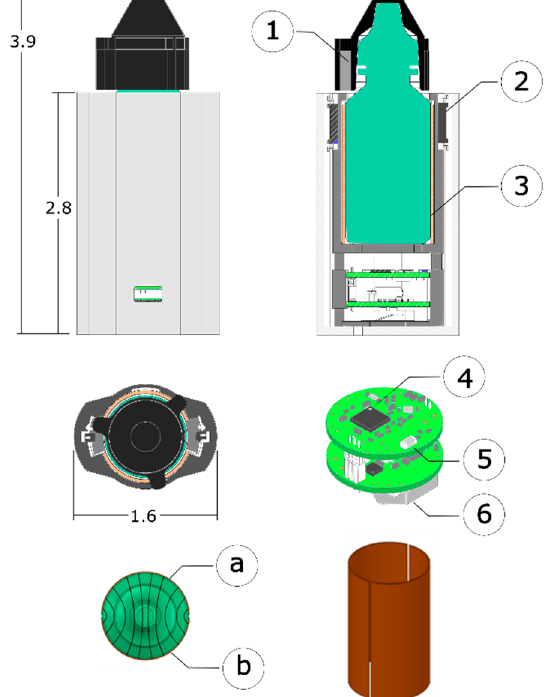
Figure 2. Mechanical layout of the bottle and sleeve assembly. ( 1 ) Bar magnets placed in the cap, and ( 2 ) reed switches in the sleeve are used to sense the cap removal. Electronics are embedded in the base of the system and were designed around an ( 4 ) nRF51422 system-on-a-chip. ( 5 ) BLE was used to transfer data, and the system was powered using ( 6 ) a single rechargeable coin cell battery. ( 3 ) The two-part capacitive sensor consisted of two rectangular copper sheets ( a ) and ( b ) surrounding the bottle. The bottom left view illustrates the electric field measured by the capacitance sensor. Table 1. Sensors and components embedded in the sleeve, along with the model number used in the prototype and the functionality of the component.